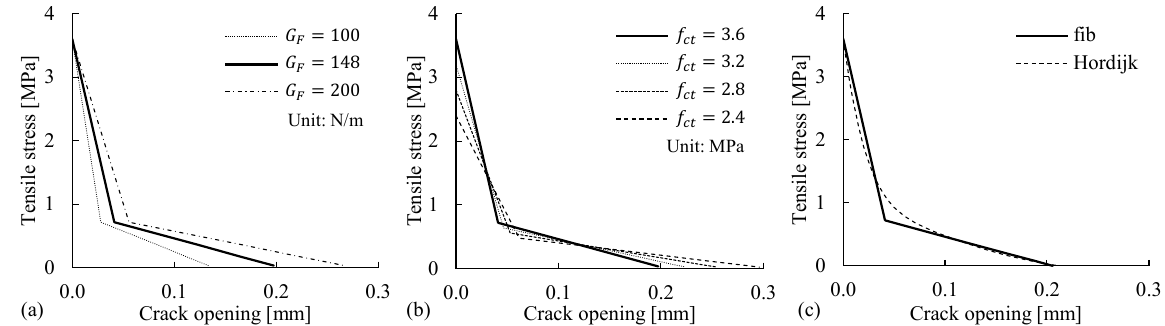
Figure 12. Concrete tensile behaviors considering ( a ) the uncertainty of the fracture energy G F , ( b ) pre-cracking at a lower tensile strength f ct , and ( c ) the differences among post-peak softening models, e.g., between Model Code 2010 [15] and Hordijk [43].